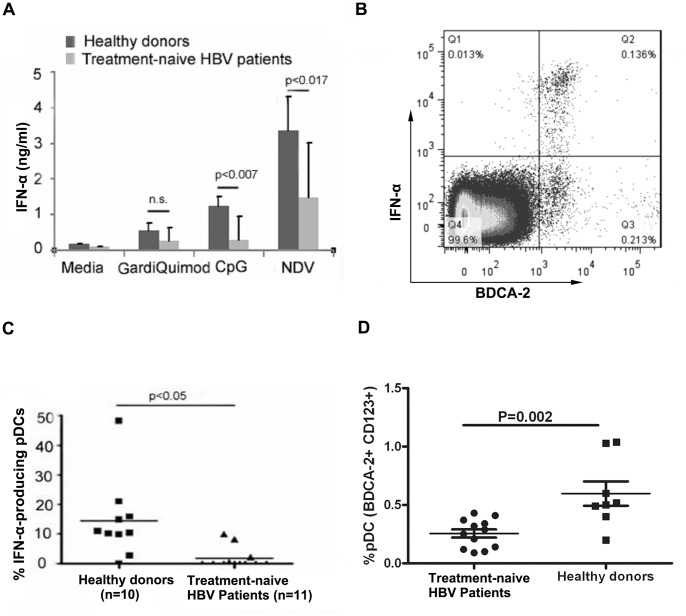
CHB patient-derived PBMCs had impaired TLR9-mediated IFN-α production.(A) Comparison of the ability of healthy donors and CHB patients to produce IFN-α. PBMCs (2×106 cells) obtained from healthy donors (n = 20) and treatment-naïve CHB patients (n = 30) were stimulated with CpG ODN2216 (TLR9 ligand, 3 µM), GardiQuimod (TLR7 ligand 1 µg/ml) or NDV (3.12 HA units/ml) for 48 hours Cell culture supernatants were collected to measure IFN-α production. (B) PBMCs (2×106 cells) from patients or healthy donors were stimulated with 3 µM CpG ODN2216 for 3 hours and brefeldin A were added to the culture supernatant while stimulation. The cells were then collected and stained with BDCA-2 and IFN-α. The IFN-α producing pDCs were then analysed. (C) Comparison of the frequency of pDCs in healthy donors and CHB patients. PBMCs from healthy donors (n = 10) and treatment-naïve CHB patients (n = 12) were surface stained with CD123-FITC and BDCA-2-APC to identify the pDC population by flow cytometry. The pDC frequency was then calculated for each healthy donor and patient. (D) Comparison of the functional pDCs ratio in healthy donors and CHB patients. PBMCs obtained from healthy donors (n = 10) and treatment-naïve CHB patients (n = 12) were stimulated with CpG ODN2216; then, the PBMCs were surface stained with CD123-PE and HLA-DR-PerCP to identify the pDC population. The cells were then fixed, and intracellular IFN-α staining was performed to identify the IFN-α producing cells. Dotted numbers indicate the percentage of IFN-α-positive cells.